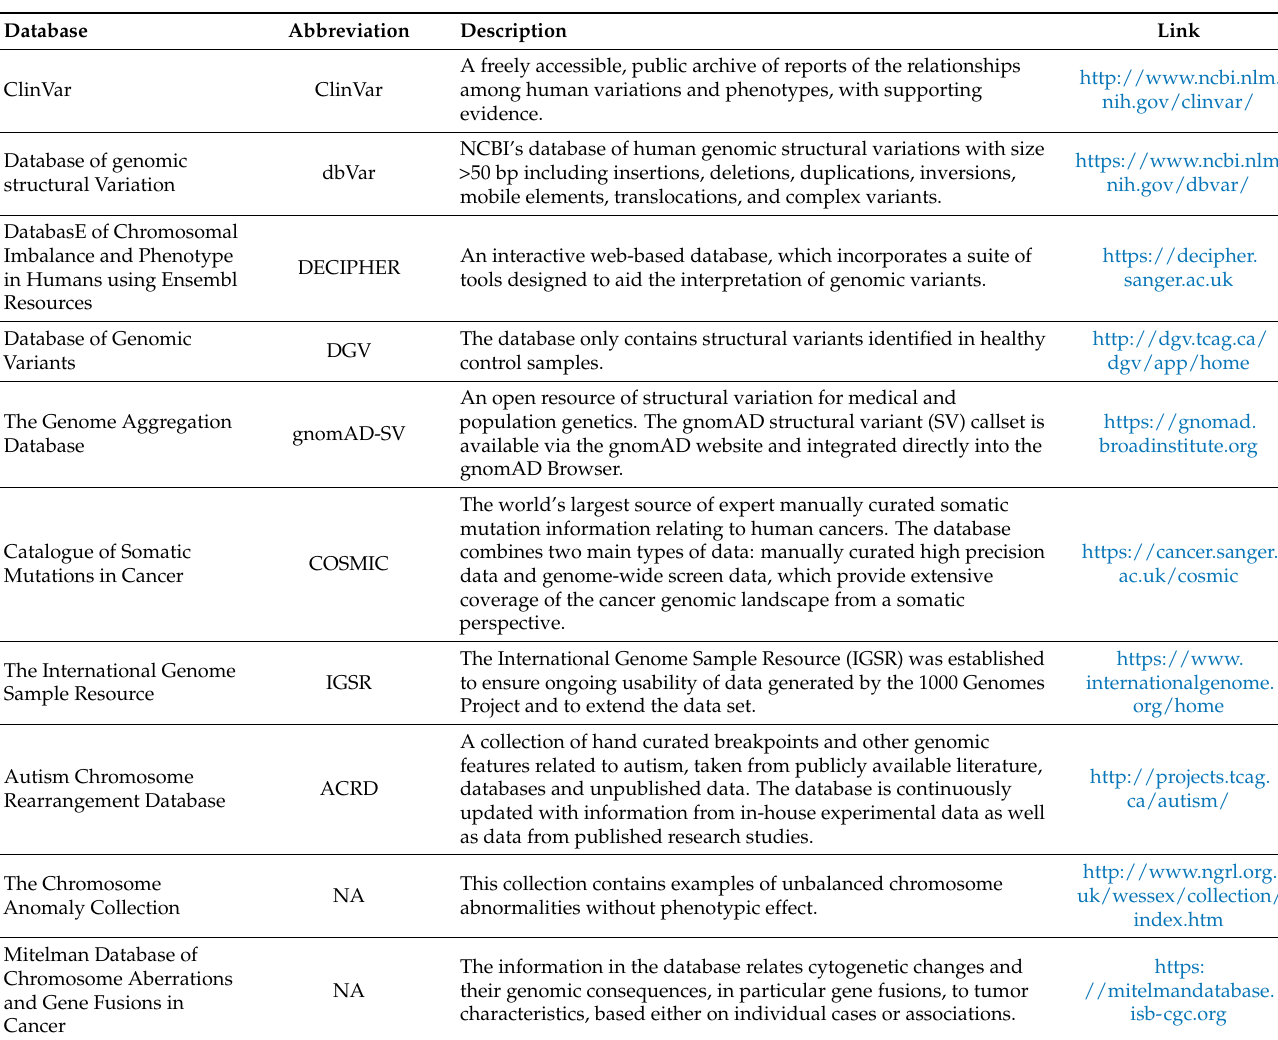
Table 3. Databases of common and clinically relevant genomic CNVs. The most popular databases that play a crucial role in variant classification are listed